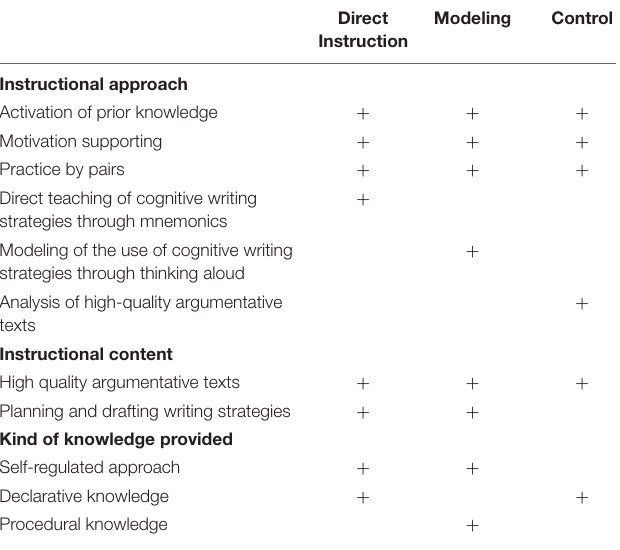
TABLE 1 | Summary of differences among